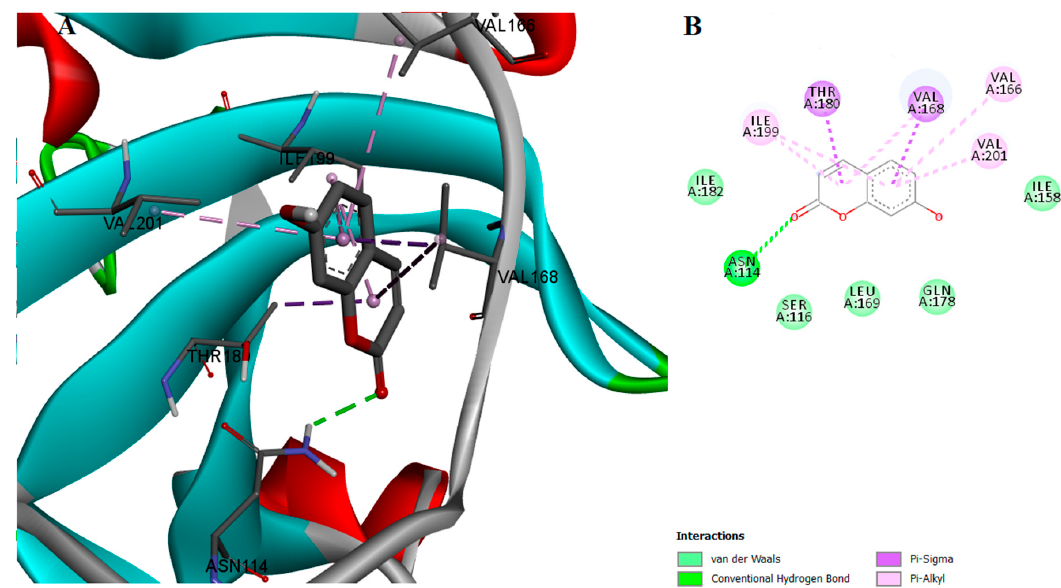
Figure 8. ( A ) Docked conformation and interactions of the umbelliferone-SrtA complex; ( B ) 2D diagram of the predicted interactions; backbone of the protein is colored in grey, β -helices in turquoise, α -helices in red and loops in green. Ligand-protein interactions are colored depending on their type: conventional hydrogen bonds are colored in green, π - σ and π -alkyl interactions are colored in purple and light purple, respectively.